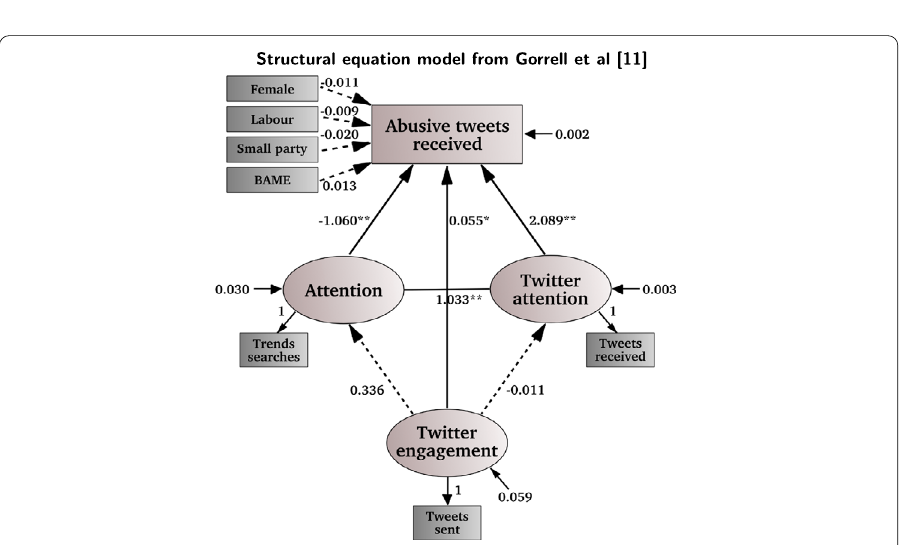
Figure 3 Structural equation model from Gorrell etal. [11]. Structural equation model from Gorrell etal. [11] shows how tweeting (“engagement”) and prominence (gauged from Trends search data) relate with